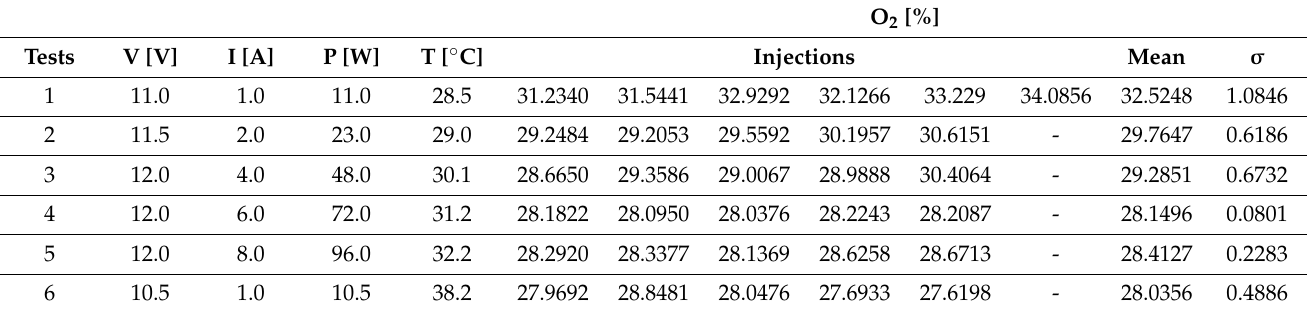
Table 3. Results of molar concentration in % of O 2 with 3% ( w/w ) of KOH.